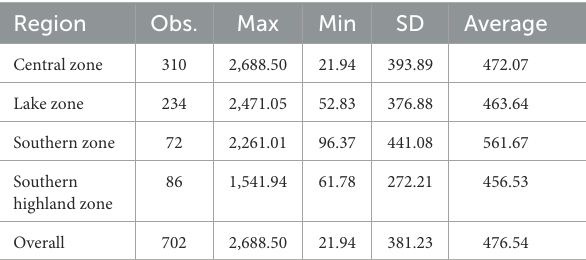
TABLE 2 Yield (kg/ha) of four regions and for the whole